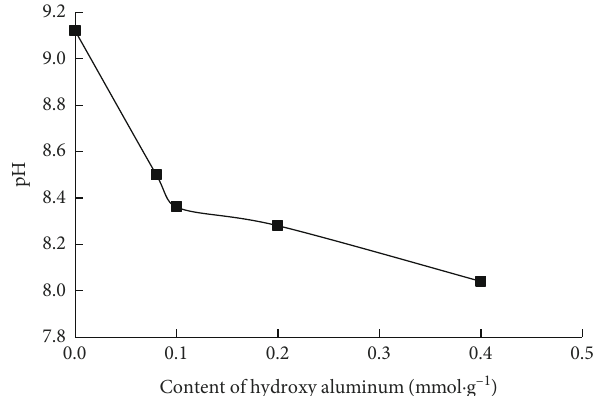
Figure 6: The curve of soil sample pH change with hydroxyl aluminum content.